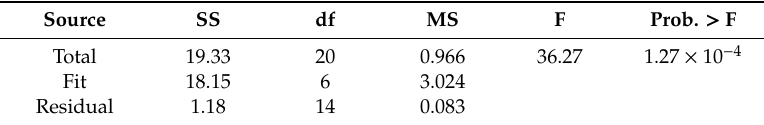
SS —sum of squares, df —degrees of freedom, MS —mean